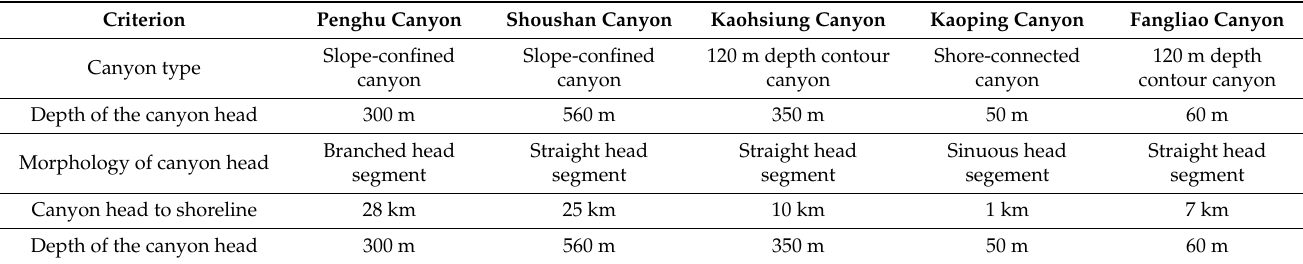
Figure 2. ( a ) River drainage and surrounding bathymetric contours of the SW Taiwan margin. Note the outline of the 120 m depth contour off the shore of SW Taiwan. ( b ) Shaded relief map of SW Taiwan. ( c ) Slope gradient map of SW Taiwan. Note that the shelves on the SW Taiwan margin are characterized by slope gradients of between 0 and 5 degrees. Five canyons occur in the shelf region off the shore of SW Taiwan: the Penghu, Shoushan, Kaohsiung, Kaoping, and Fangliao Canyons. Hongtsi Sea Valley is situated east of the Fangliao Canyon. Table 2. Comparisons of submarine canyons along the SW Taiwan margin.